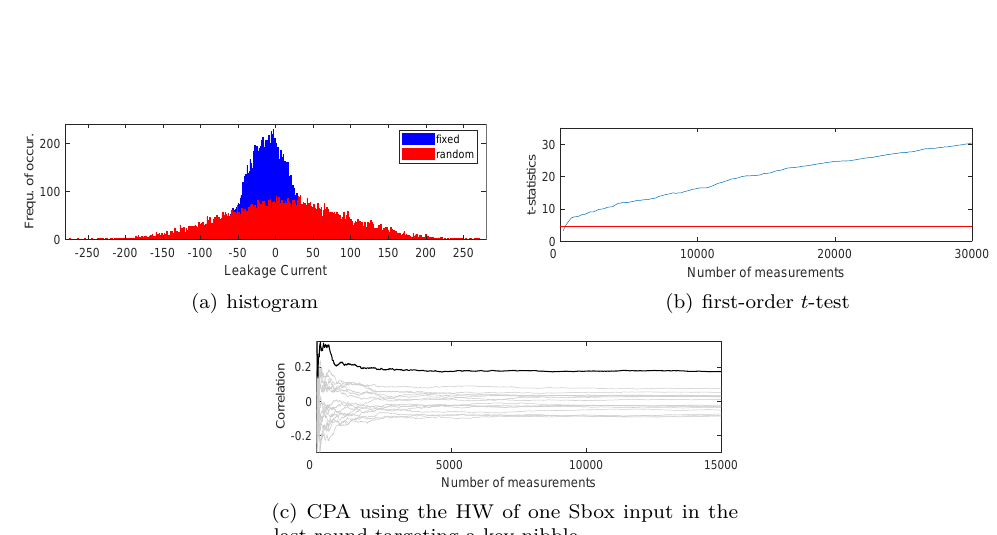
Figure 14: Leakage evaluation and attack using 30,000 fixed vs. random measurements of a nibble-serial implementation of the SKINNY block cipher in 65 nm CMOS technology, recorded at 90 ◦ C and 1 . 6 V.